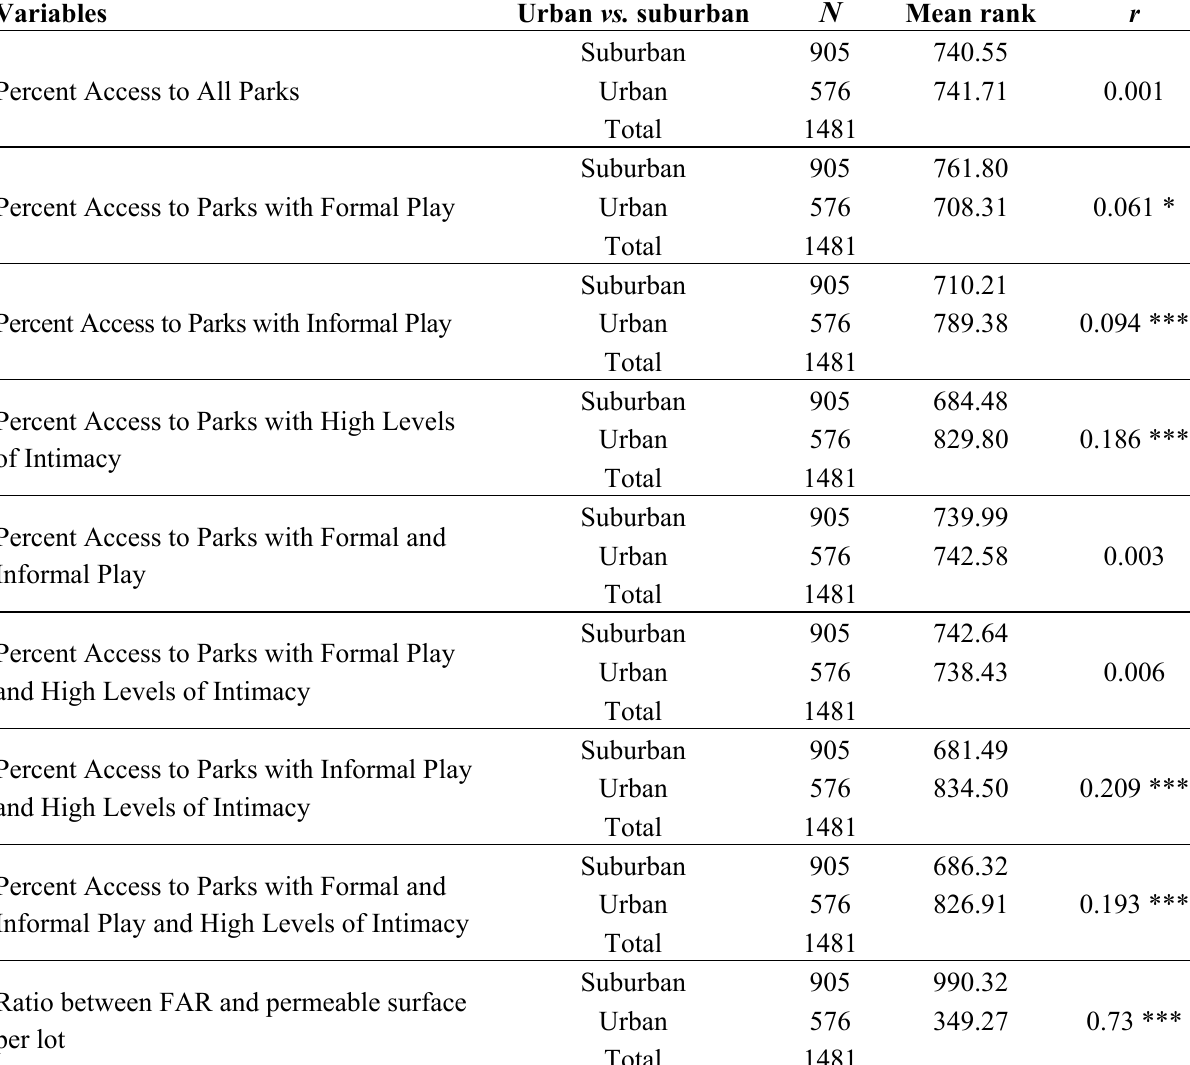
Table 6. Effect sizes between urban and suburban neighborhoods for access to different types of parks and for the ratio between Floor area ratio (FAR) and permeable surfaces per lot from the Mann Whitney U